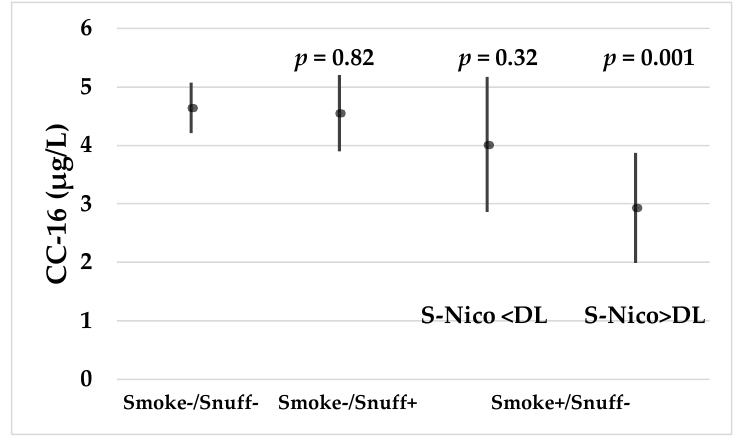
Figure 3. The mean (and 95% CI) concentrations of CC-16 in non-smokers/non-snuffers, non-smokers/snuffers and smokers/non-snuffers according to serum nicotine (S-Nico) concentrations that were higher or lower than the methods’ detection limit. The estimates are adjusted for time of sampling. The p -values refer to differences between the group of non-smokers/non-snuffers and the three other groups, respectively. Table 4. Statistically significant results from multiple linear regression analysis (backward procedure). Dependent variables were the concentrations of C-reactive protein (CRP), club cell protein 16 (CC-16) and surfactant protein D (SP-D) at baseline. Independent variables were exposure category (Expo) (0/1), age (years), infection (0/1), body mass index (BMI) (kg/m 2 ), sampling time (minutes since midnight) and current tobacco smoking (0/1). Beta-coefficients and corresponding p - values are presented.